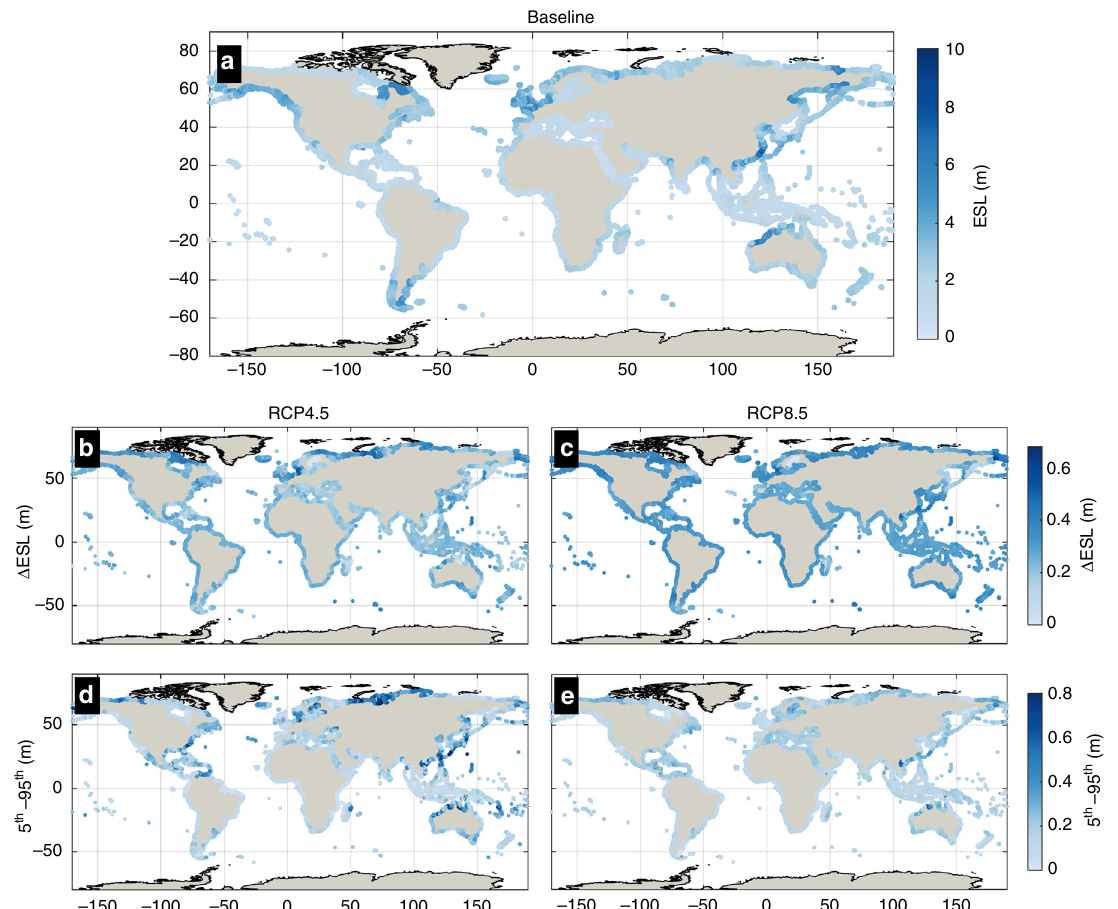
Fig. 2 Present global ESLs, changes in view of climate change and uncertainty. Maps show the median present-day 100-year ESL ( a ) and the projected changes in ESL 100 expressed by the median and the very likely range under RCP4.5 ( b , d ) and RCP8.5 ( c , e ) by